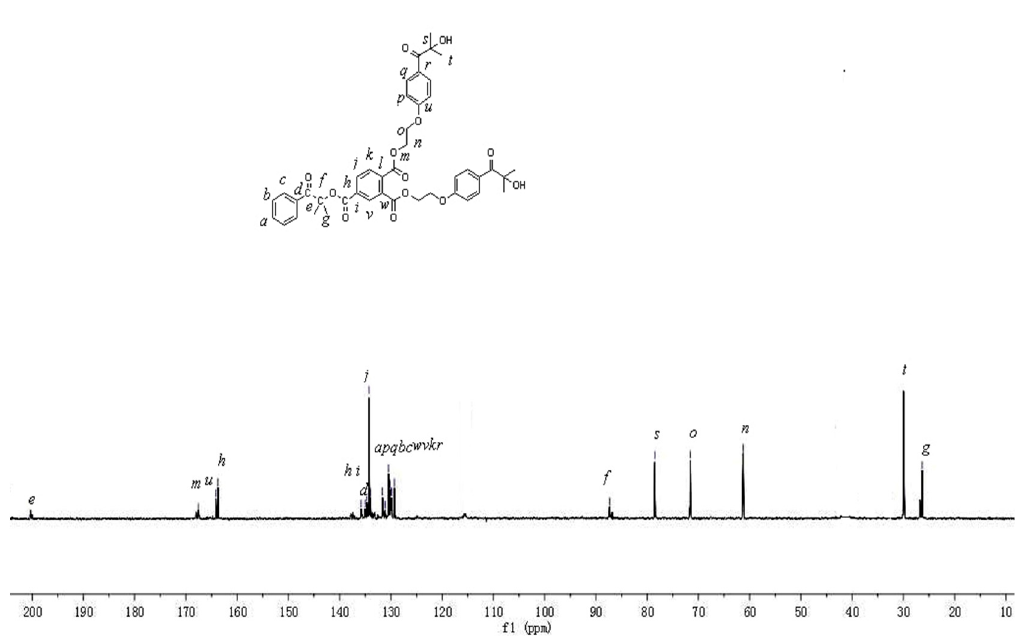
Figure 3. 1 H NMR spectrum of HTH.